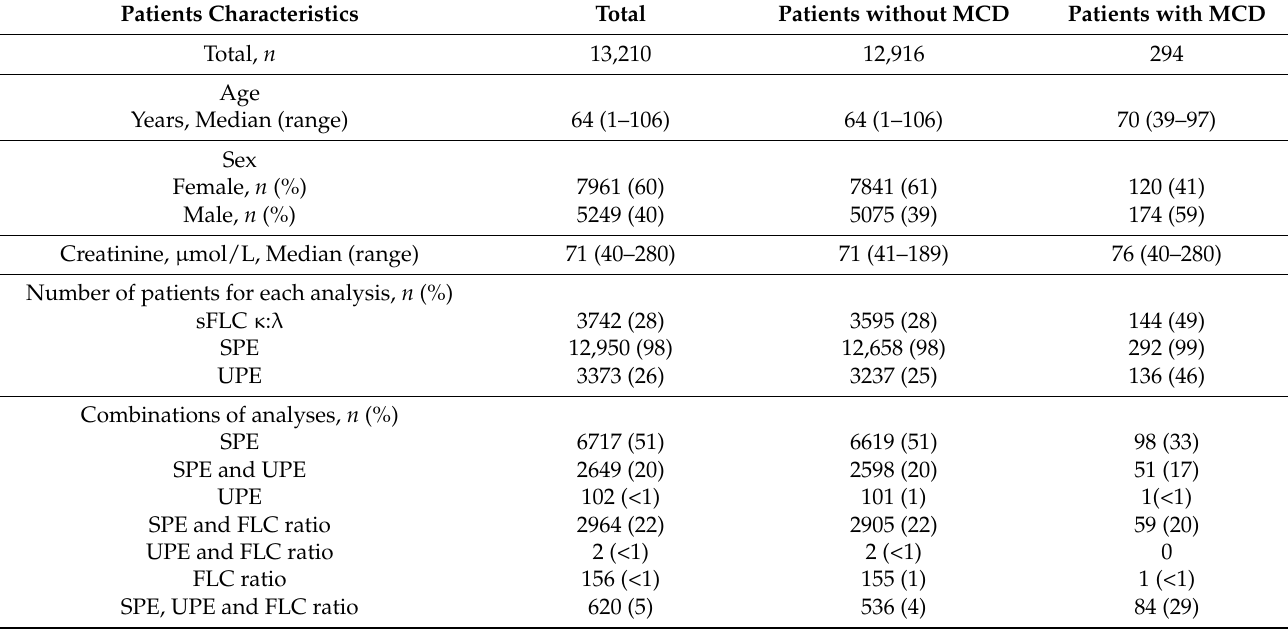
Figure 1. Flowchart.* MCD: monoclonal disease that includes Myelomatosis, MGUS, plasmacytoma, amyloidosis, heavy chain disease and Waldenstrom macroglobulinemia. Table 1. Patients characteristics.